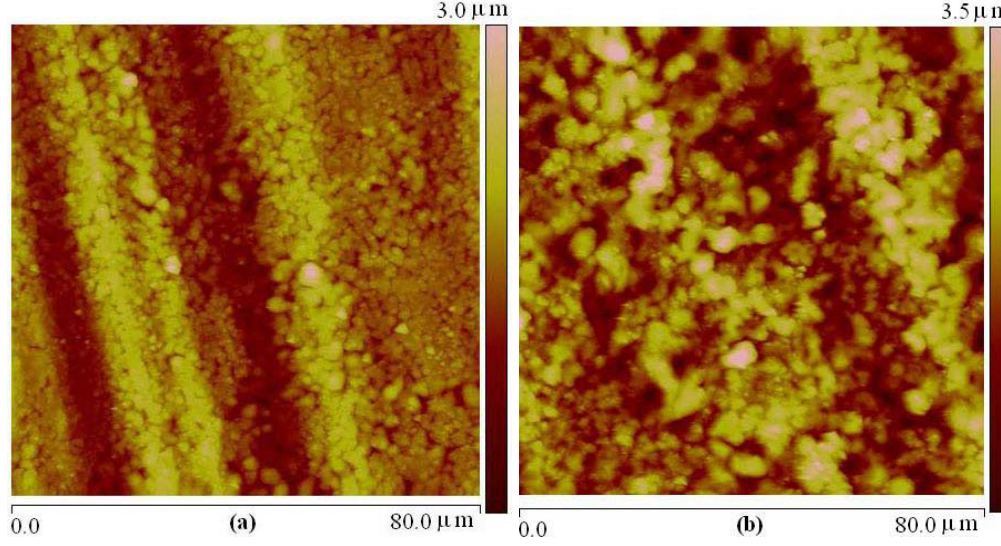
Figure 1. AFM surface morphology of microarc oxidation coating formed in different treatment period: (a) 5 min; (b) 15 min; (c)